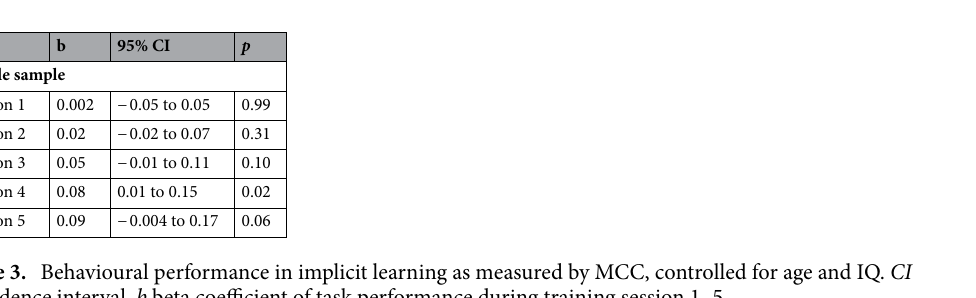
Figure 2. MCC mean learning rates over five sessions for both daily and intensive training regimens measured with MCC. S session, MCC Matthew’s correlation coefficient, higher values indicate better performance. # significant difference. Error bars represent standard errors.